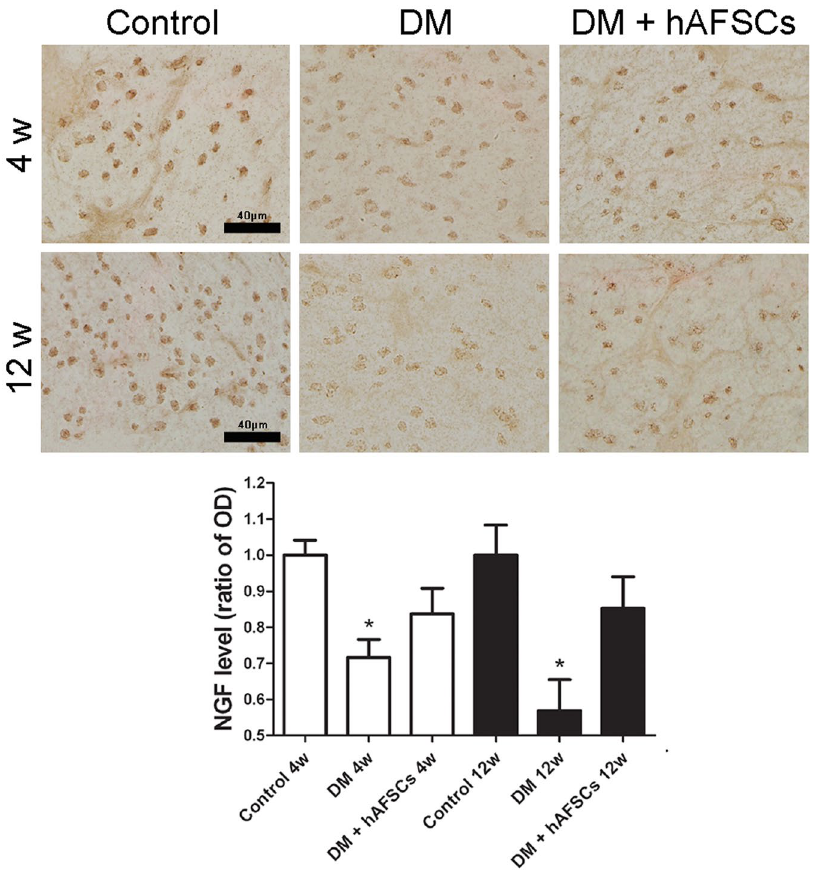
Figure 4. Temporal expressions of nerve growth factor (NGF) immunoreactivity in the bladder of control, STZ- induced diabetic rats (DM) and diabetic rats + hAFSCs transplantation (DM + hAFSCs). The immunoreactivity of NGF can be seen in control rats ( A ), diabetic rats ( B ), and diabetic rats + hAFSCs transplantation ( C ) at 4 weeks, and in control rats ( D ), diabetic rats ( E ), and diabetic rats + hAFSCs transplantation ( F ) at 12 weeks. When compared to the controls, the expressions of NGF in the diabetic rats are significantly decreased, but can be recovered to near the control level after hAFSCs transplantation. OD = optical density. Bar indicates 40 μ m. * P < 0.05 vs. control group. N = 10 in each time